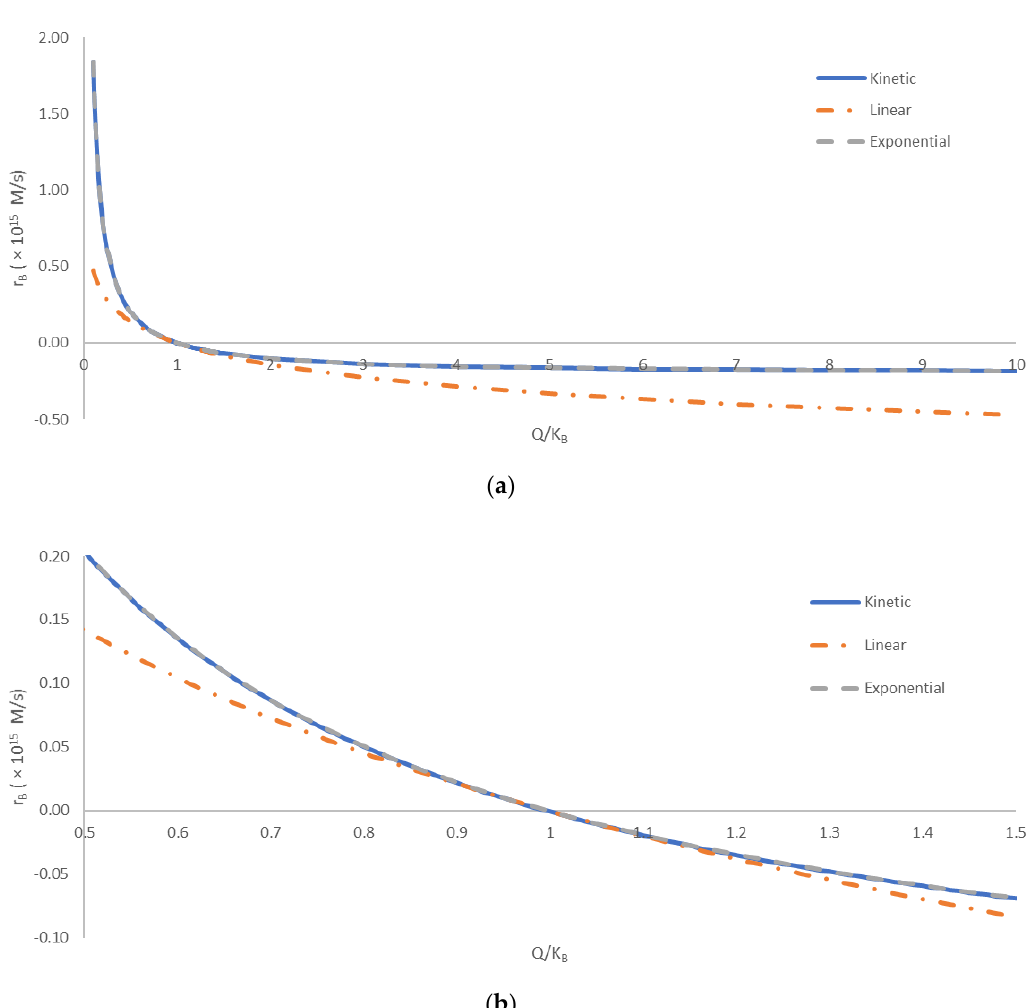
Figure 1. A comparison of the kinetic, linear, and exponential methods for calculating the overall binding rate, r B . The comparison was made for various distances from equilibrium, quantified by Q / K B . The equilibrium corresponds to Q / K B = 1. The region where Q / K B < 1 corresponds to the reaction being incomplete, with unreacted reactants that will form the product once the equilibrium is achieved. The region where Q / K B > 1 corresponds to the reaction “overshooting” the equilibrium, with excess product formed that will decompose into the reactants when the equilibrium is reached. ( a ) A comparison over a wide span of Q / K B , from 0.1 to 10. ( b ) Comparison close to equilibrium, with Q / K B between 0.5 and 1.5. The full blue line ( ― ) represents the kinetic method, the orange dot-and-dash line ( - ∙ - ) represents the linear method, while the dashed gray line ( - - - ) represents the exponential method. The calculated overall binding rates have been multiplied by 10 15 for clearer presentation.